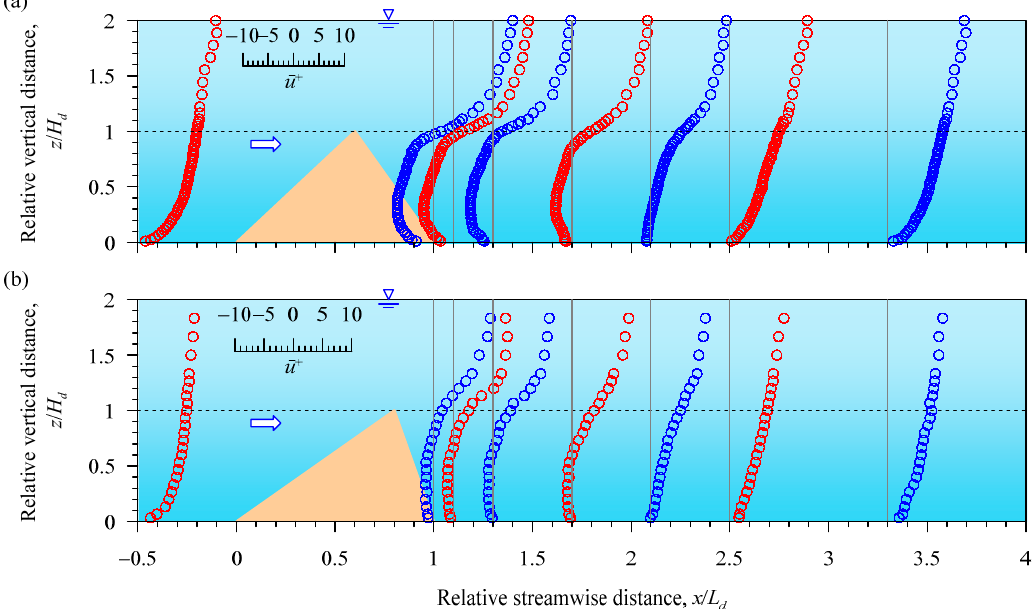
Figure 5. Vertical profiles of nondimensional streamwise flow velocity ¯u + at the upstream and various downstream relative streamwise distances x / L d of isolated dunal bedforms for ( a ) Run 1 and ( b ) Run